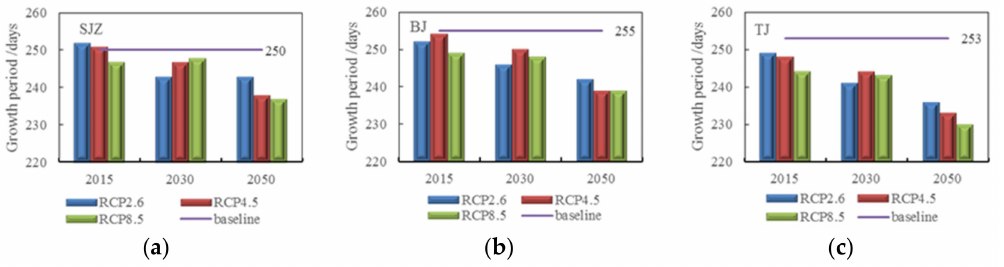
Figure 5. The growing period of wheat in the different RCP scenarios. ( a – c ) are growth period for Shijiazhuang, Beijing, and Tianjin, respectively.